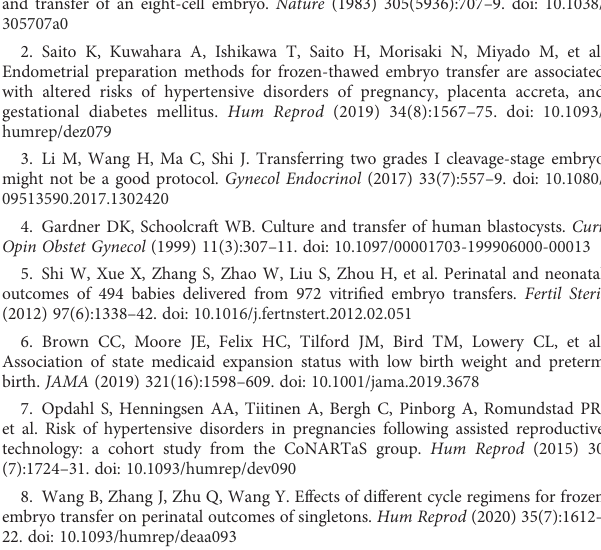
SUPPLEMENTARY FIGURE 1 Subgroup analysis of different FET regimens on